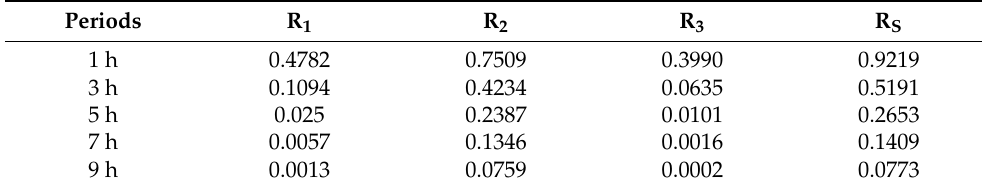
Table 12. Reliability of subsystems and the man–machine system during five time periods for the period from 17 to 28 May